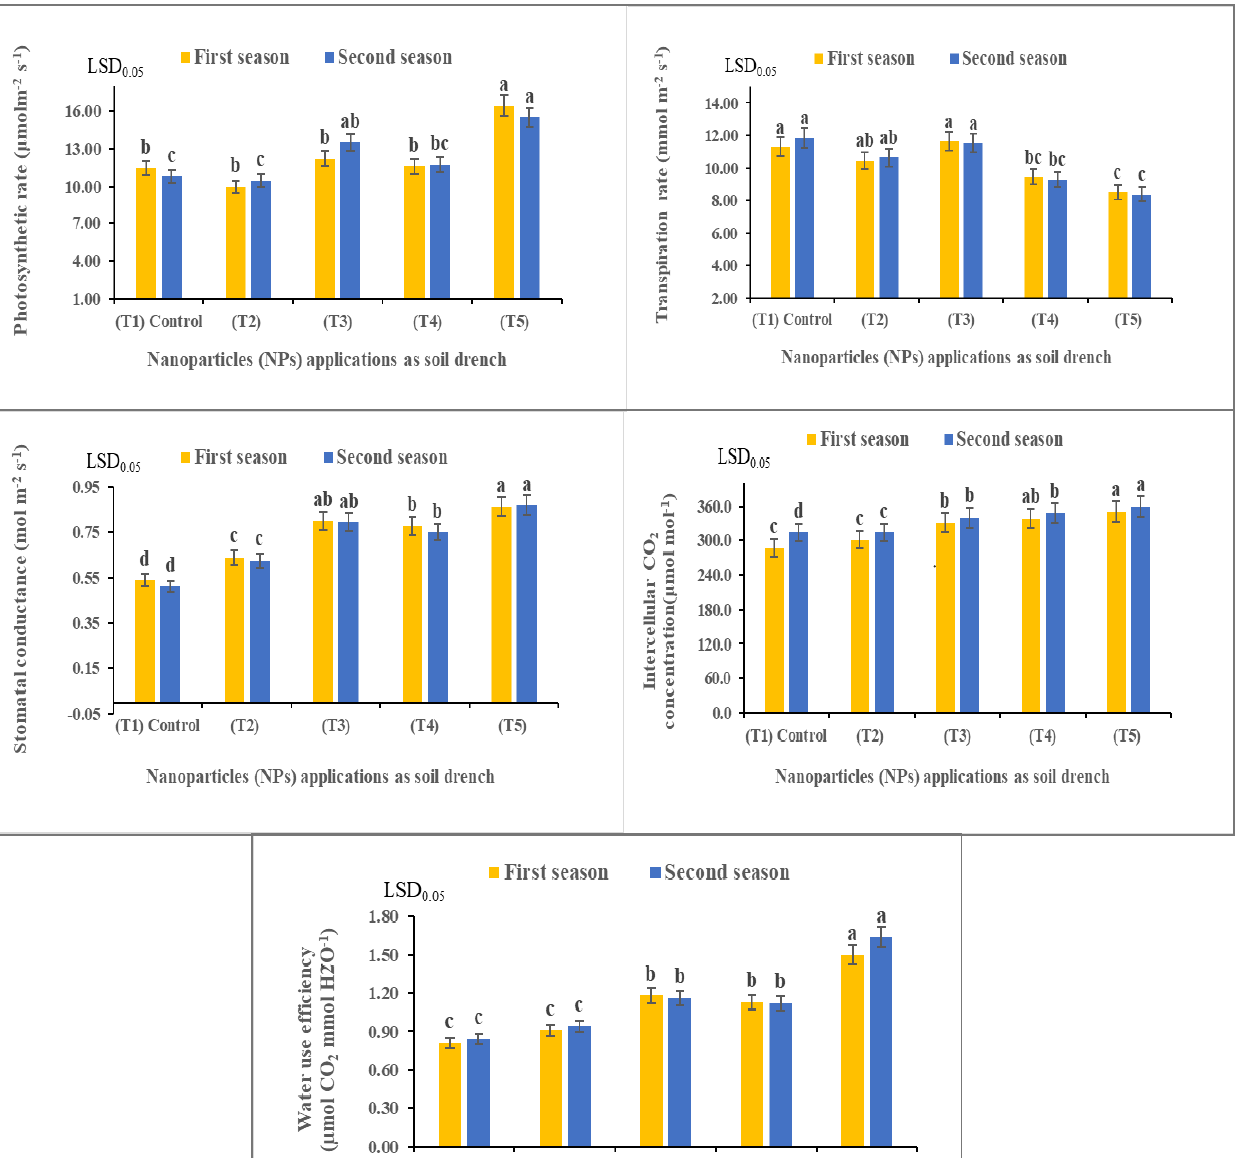
Figure 6. Photosynthetic rate, stomatal conductance, leaf transpiration rate, intercellular CO 2 concentration, and water use efficiency under drought conditions and different nanoparticle applications on Solidago canadensis plants during the 2020 and 2021 growing seasons. Different letters show statistically significant differences declared by Duncan’s Multiple Range Test LSD at p ≤ 0.05. (T1) NPK= chemical fertilizer, (T2) n-Si= silicon nanoparticles, (T3) n-NPK= NPK nanoparticles, (T4) n-ZE-loaded N= nano-zeolite-loaded nitrogen, (T5) n-Si+ n-ZE-loaded N= silicon nanoparticles+ nano-zeolite-loaded